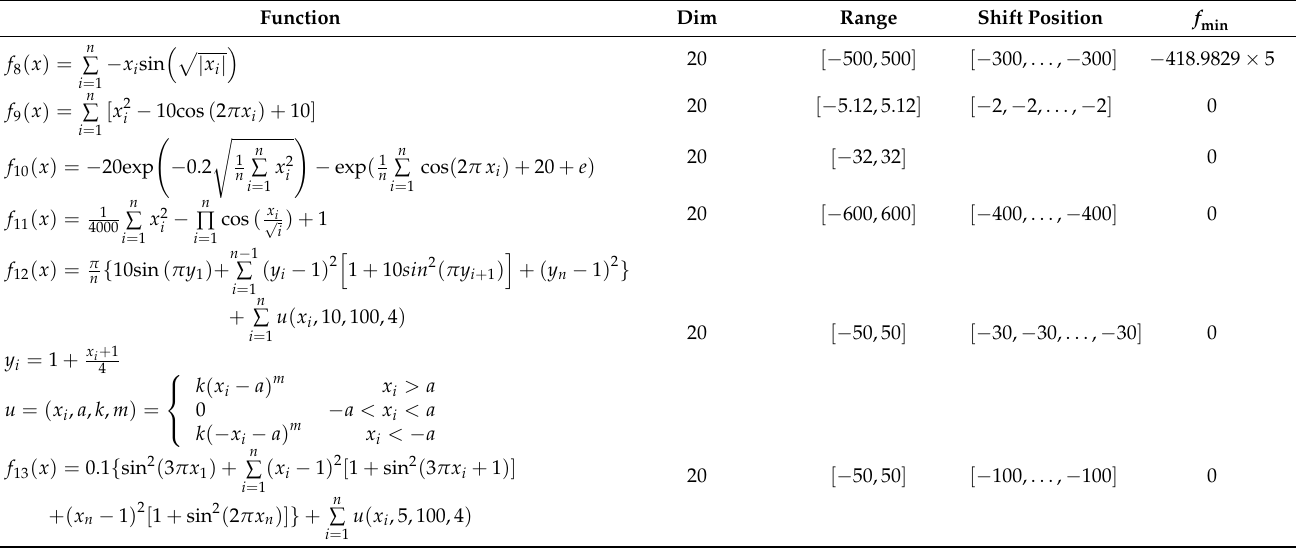
Table A2. Multimodal test functions.